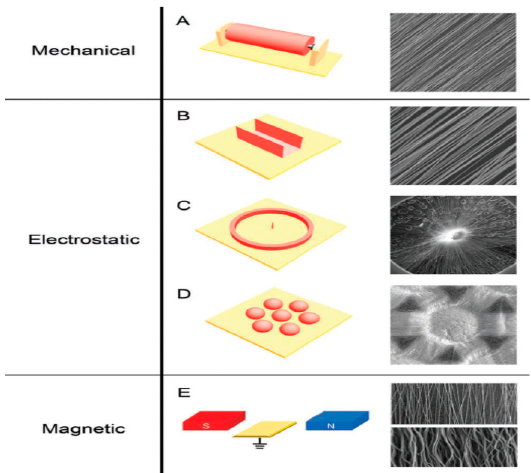
Figure 10. Schematics of electrospinning methods to direct fiber orientation by means of mechanical rotation of mandrel ( A ), electrostatic forces through the use of a metallic staple ( B ), a metallic ring ( C ), and an array of metallic beads ( D ), as well as magnetic forces through the use of a pair of permanent magnets ( E ). The yellow plates are grounded conductive electrodes. Scanning electron micrographs in the right panel show the morphologies of aligned nanofibers depositing at the target via different methods. Reproduced with permission from [120], published by Wiley-VCH, 2012. Reproduced with permission from [121], published by American Chemical Society, 2010.